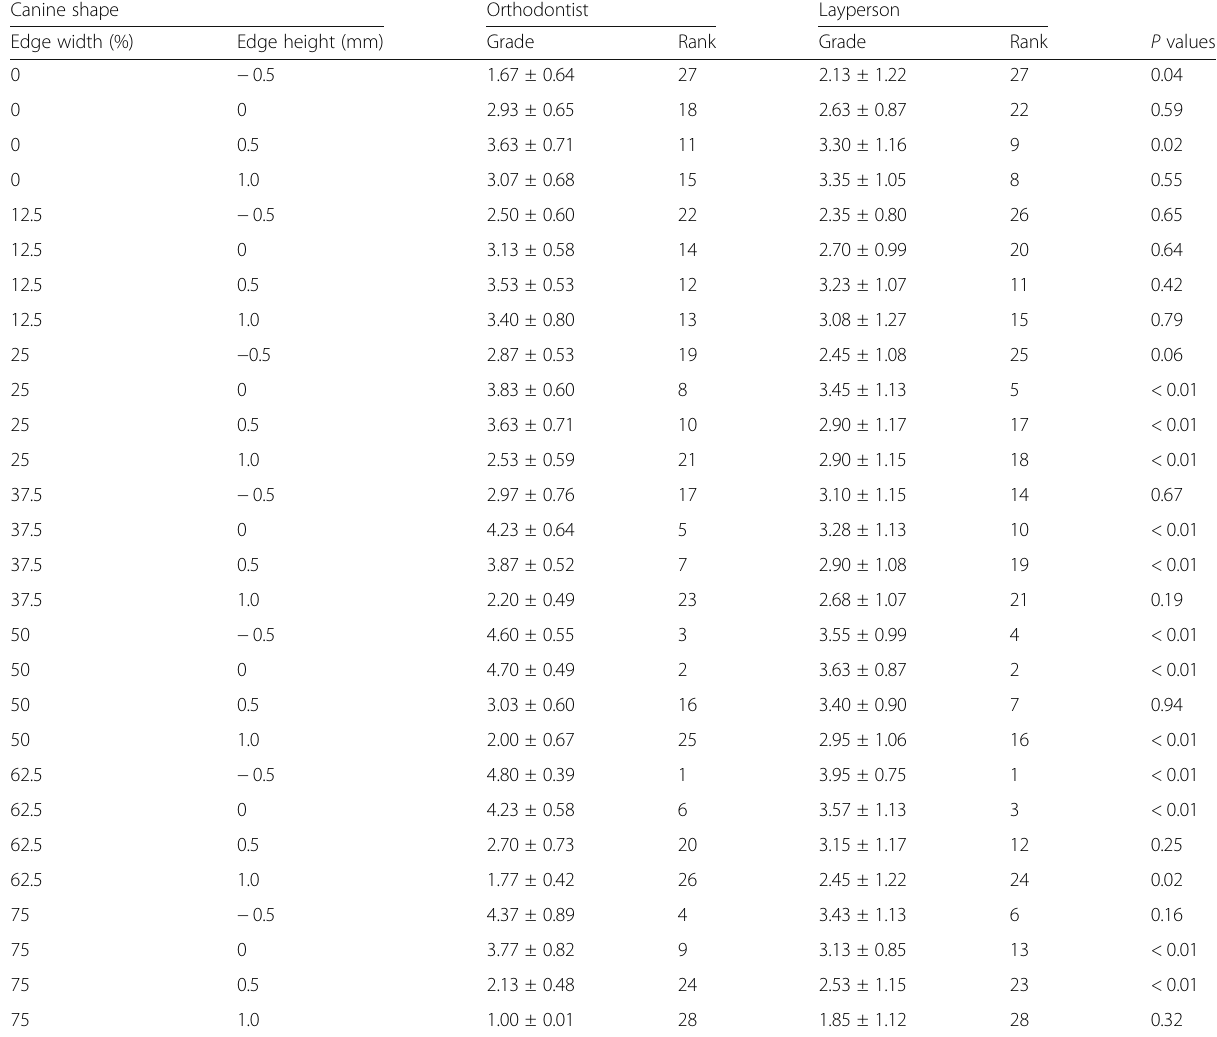
Table 3 Esthetic grade (mean ± standard deviation) and rank on the canine shape by the orthodontists and laypersons. The P values were based on the chi-square and Fisher ’ s exact tests between the orthodontists ’ and laypersons ’ grades Canine shape